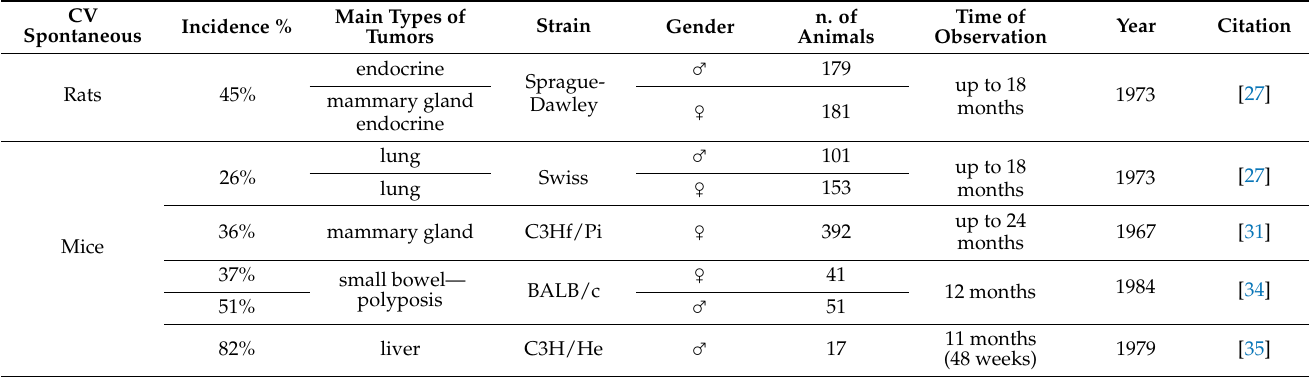
Table 1. Spontaneous tumors in conventional experimental rats and mice.